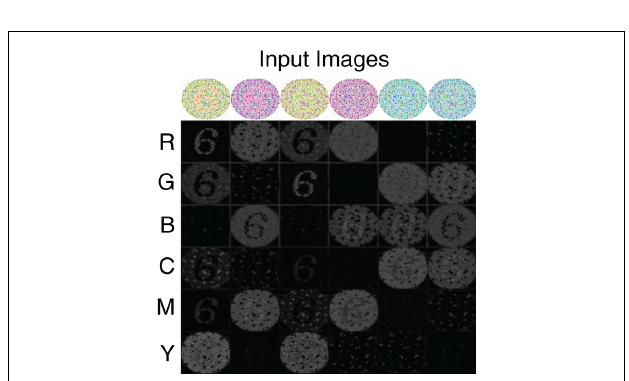
FIGURE 3 |V4 responses to colorblind test images. Six versions of the same test image with the number 6 are used (top row).The color composition is varied so as to activate different color populations.The response of the six color regions (rows) to the six test images (columns) is shown in gray scale: no response is black and highest response is white. As one can see, under most configurations the number “6” pops-out in the neural